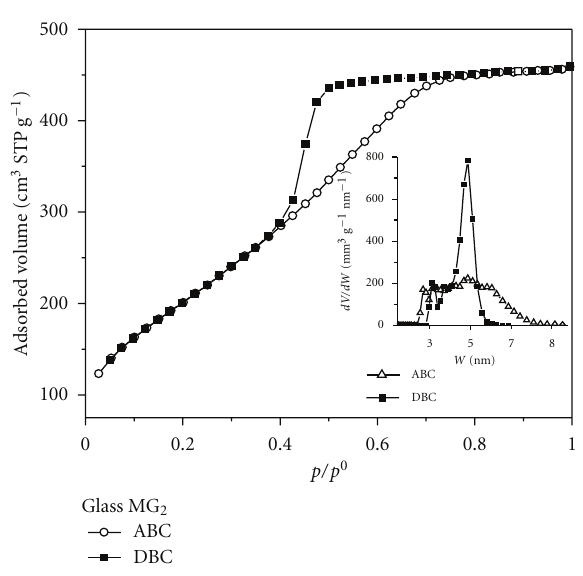
Figure 9: N 2 sorption on (a) MG 2 undoped.